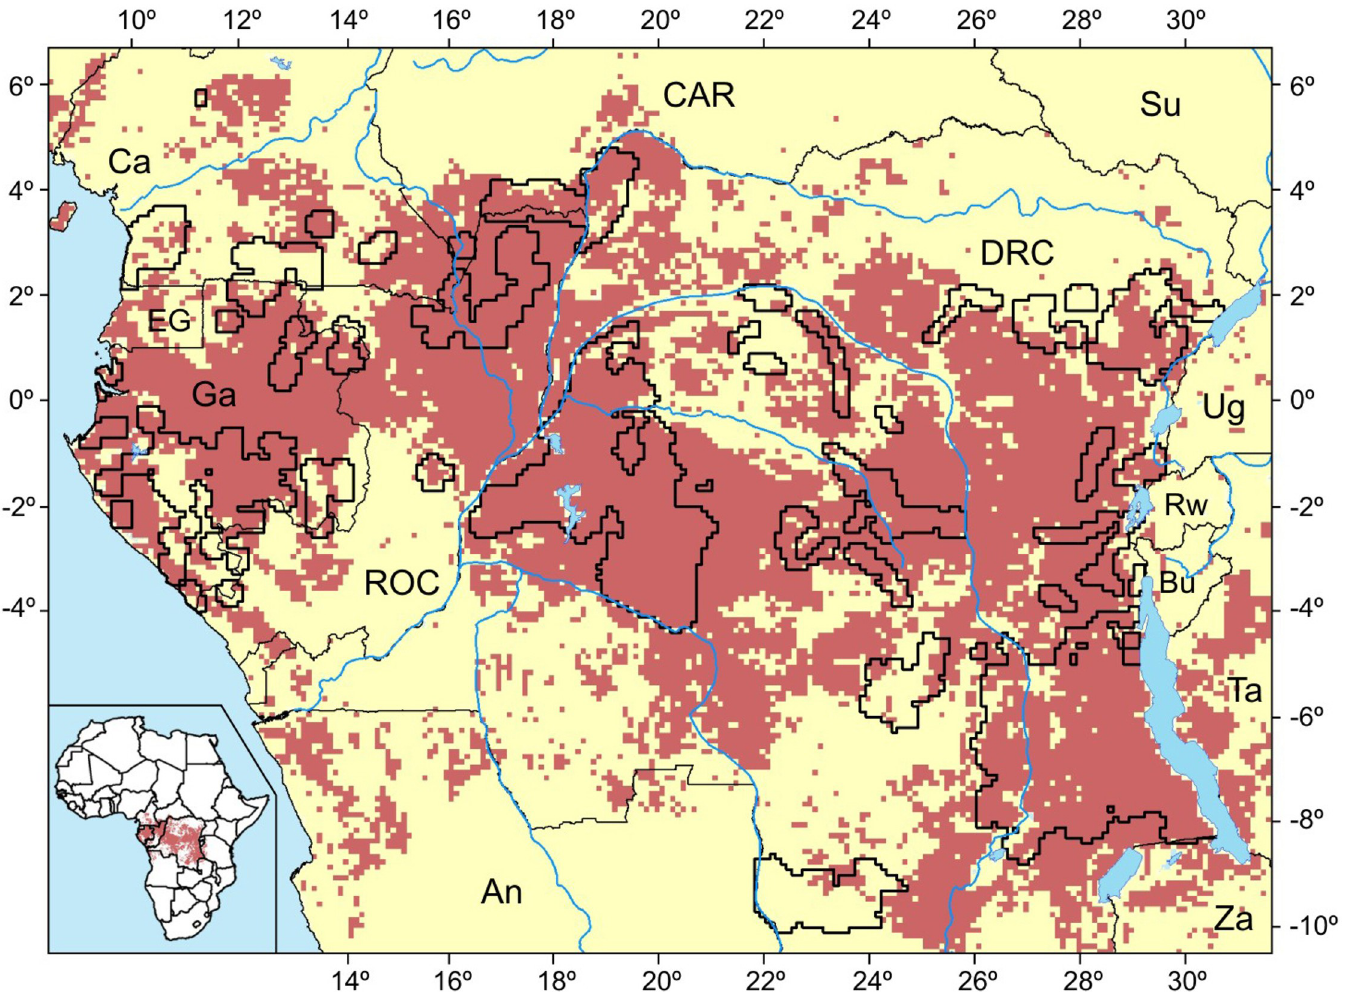
Fig 1. Environmental favourability (F) model for Pygmies. Red: F > 0.5; yellow: F < F. Presence areas are delimited with a thick black line. (Ca: Cameroon; CAR: Central African Republic; Su: Sudan; EG: Equatorial Guinea; Ga: Gambia; RoC: Republic of Congo; DRC: Democratic Republic of the Congo; Ug: Uganda; Rw: